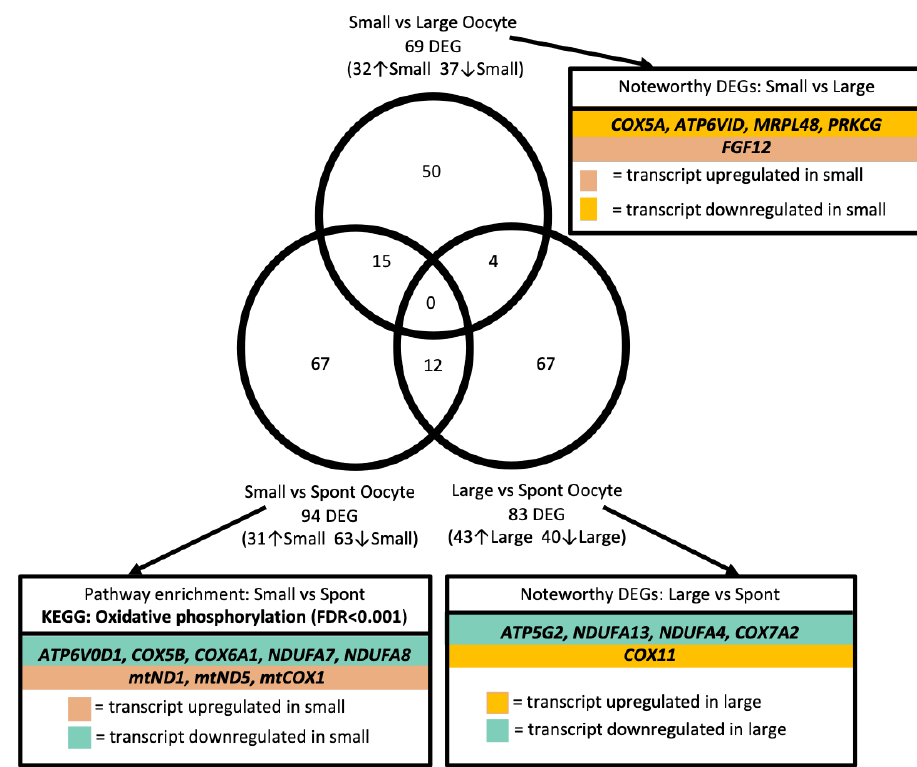
Figure 2. Differential gene transcript abundance among oocyte pools. Venn diagram displaying 69, 94, and 83 differentially abundant gene transcripts (DEGs) in comparisons of Small vs. Large, Small vs. Spontaneous (Spont), and Large vs. Spont oocyte pools, respectively. A total of 50, 67, and 67 DEGs were identified in only Small vs. Large, Small vs. Spont, or Large vs. Spont oocyte comparisons, respectively. A total of 15 transcripts were identified as DEGs in both Small vs. Large and Small vs. Spont comparisons; 4 transcripts were identified as DEGs in both Small vs. Large and Large vs. Spont comparisons; and 12 transcripts were identified in both Small vs. Spont and Large vs. Spont comparisons. No transcripts appeared as DEGs in all three comparisons of follicle classifications. The KEGG pathway significantly enriched with DEGs, alongside additional noteworthy DEGs, are indicated for each comparison.